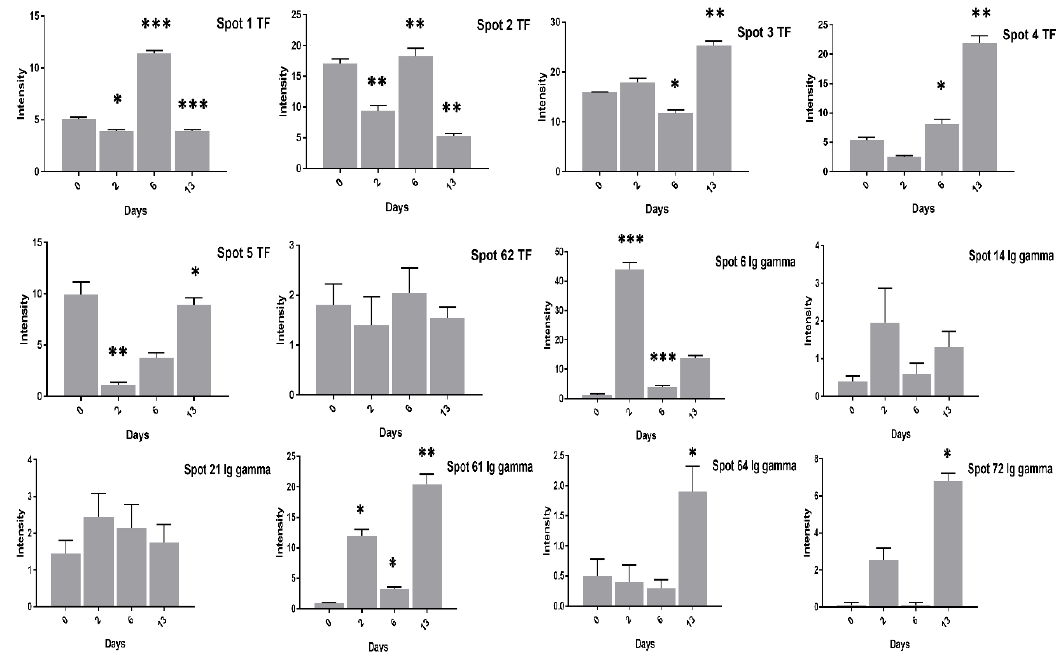
Figure 8. Changes in the intensity of TF and Ig gamma proteins after 0, 2, 6, and 13 days of incubation was shown in low cholesterol eggs. Column profiles of TF (1–5, 63) and Ig gamma (6, 14, 21, 61, 64, 72) protein spots were shown as bar charts. Asterisks denote significant differences at different incubation days. The error bars represent the standard deviation. * p < 0.05, ** p < 0.005, *** p < 0.0001.